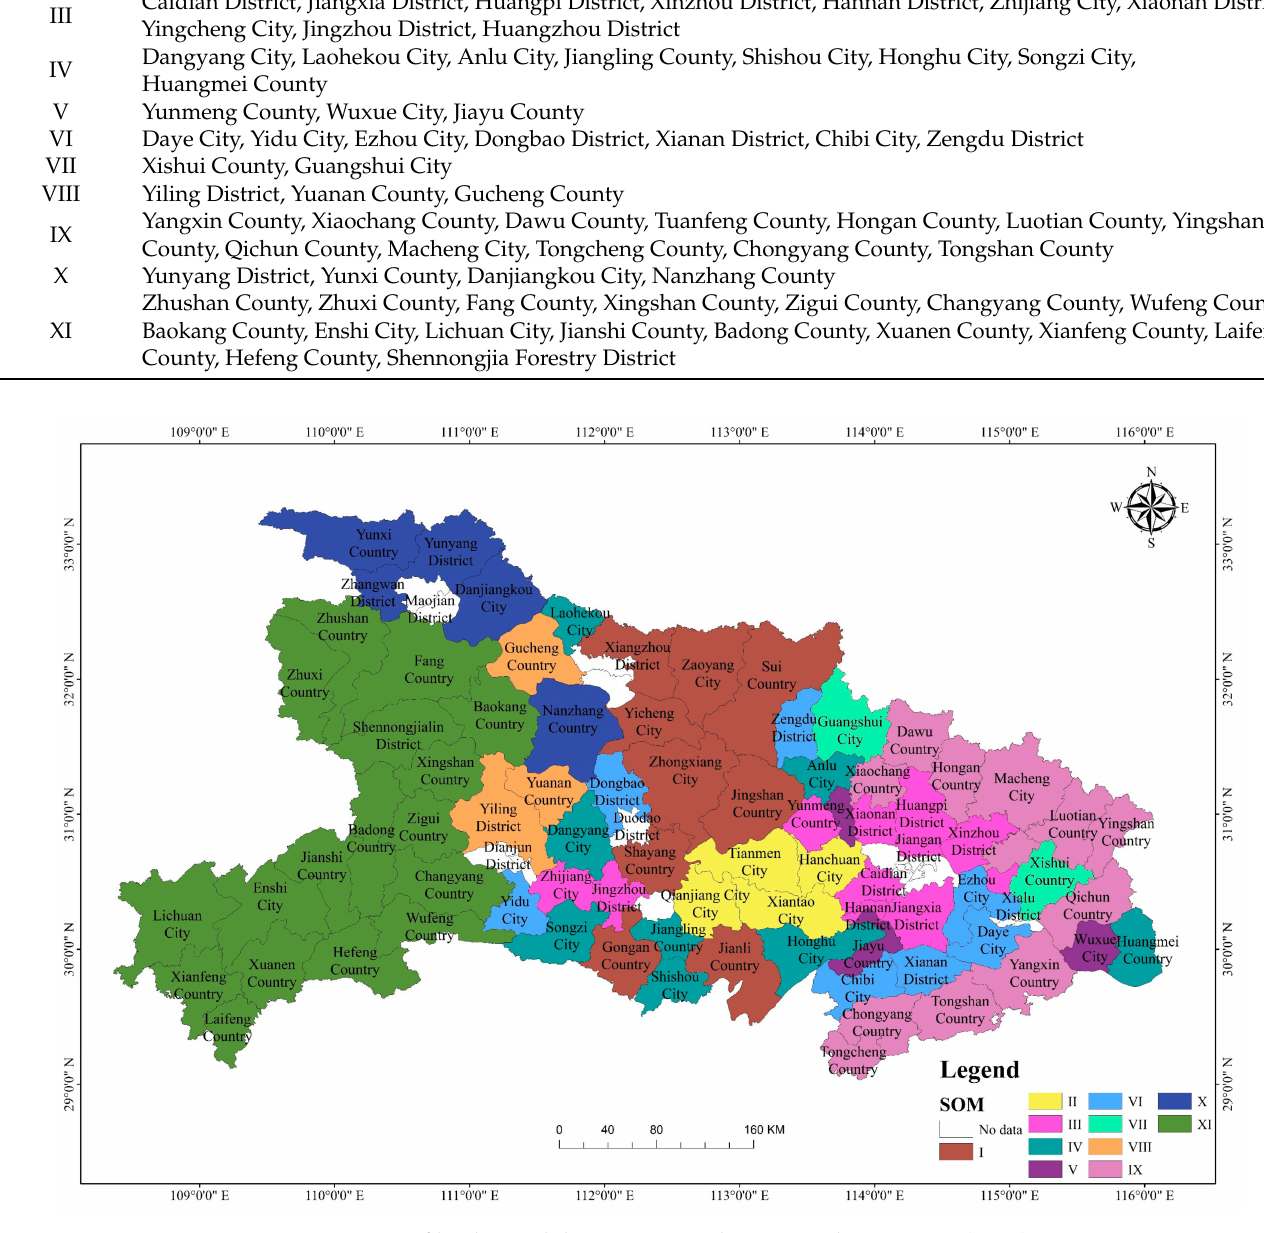
Figure 5. Map of land consolidation zoning scheme in Hubei province